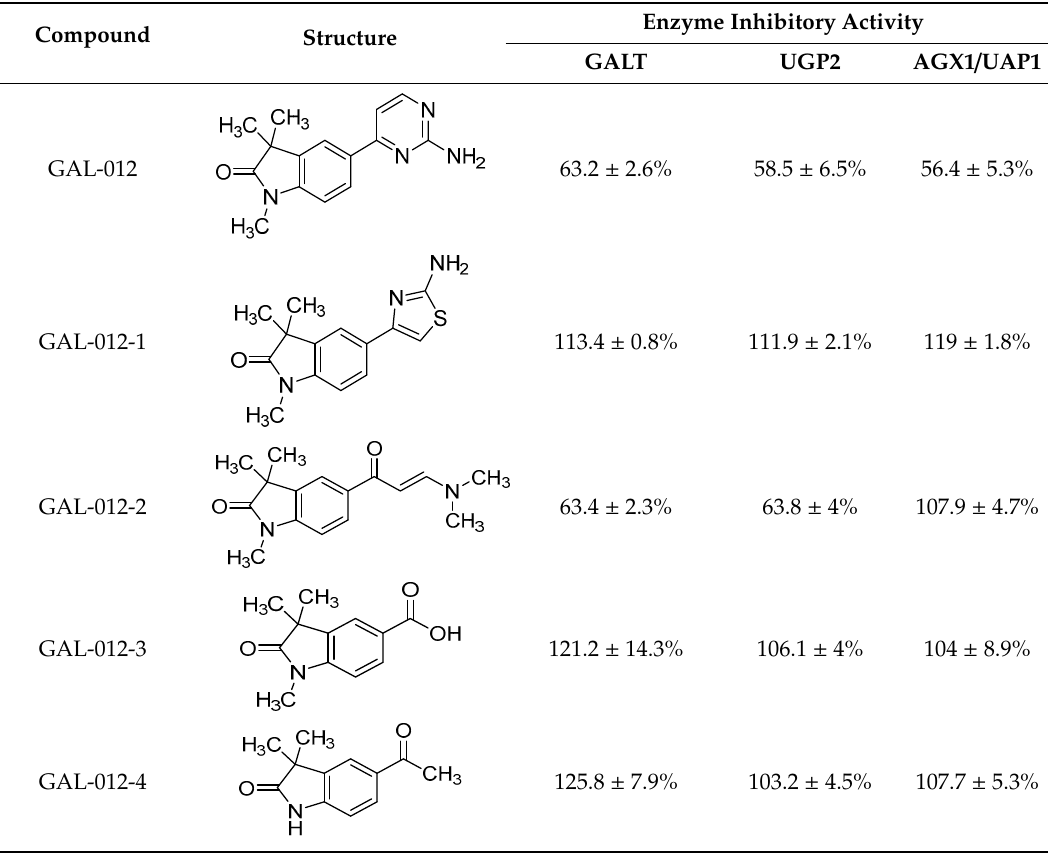
Table 1. Inhibitory Activity of GAL-012 series to GALT, UGP2 and AGX1 / UAP1. Compound